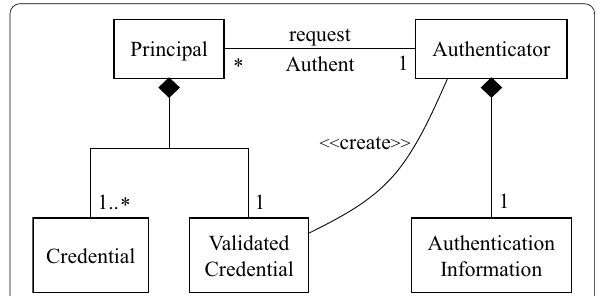
Fig. 3 Class diagram of the credential-based authenticator pattern